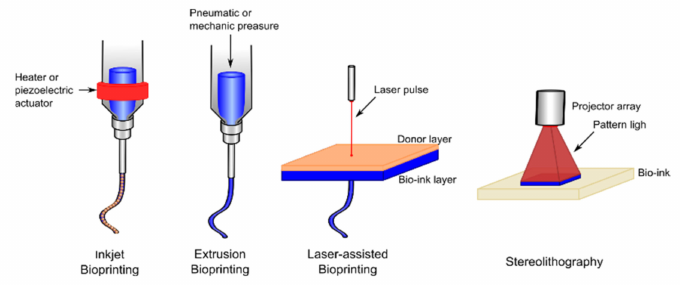
Figure 6. Schematic representation of bioprinting